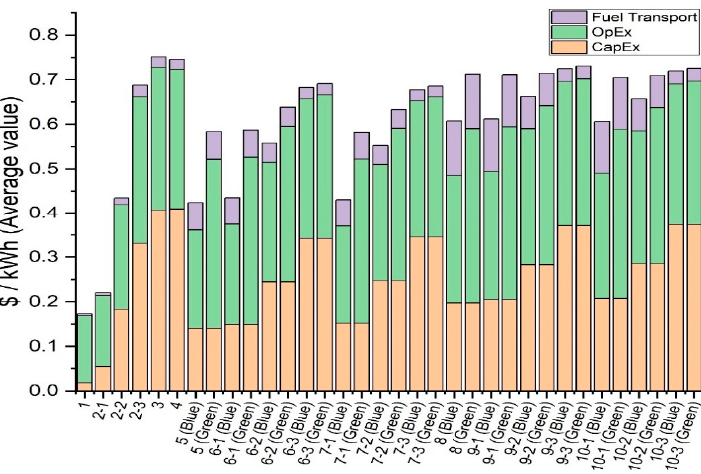
Figure 6. Levelised value of total cost, including CapEx, OpEx, and fuel transport.